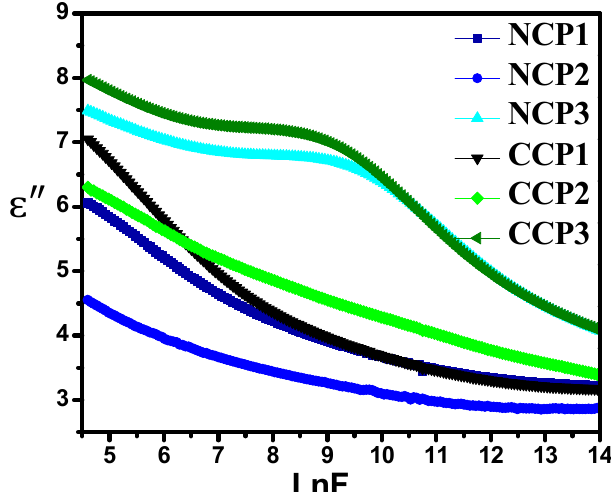
Figure 10. Variation in dielectric loss with varying concentrations of nanofillers at different frequen- cies.